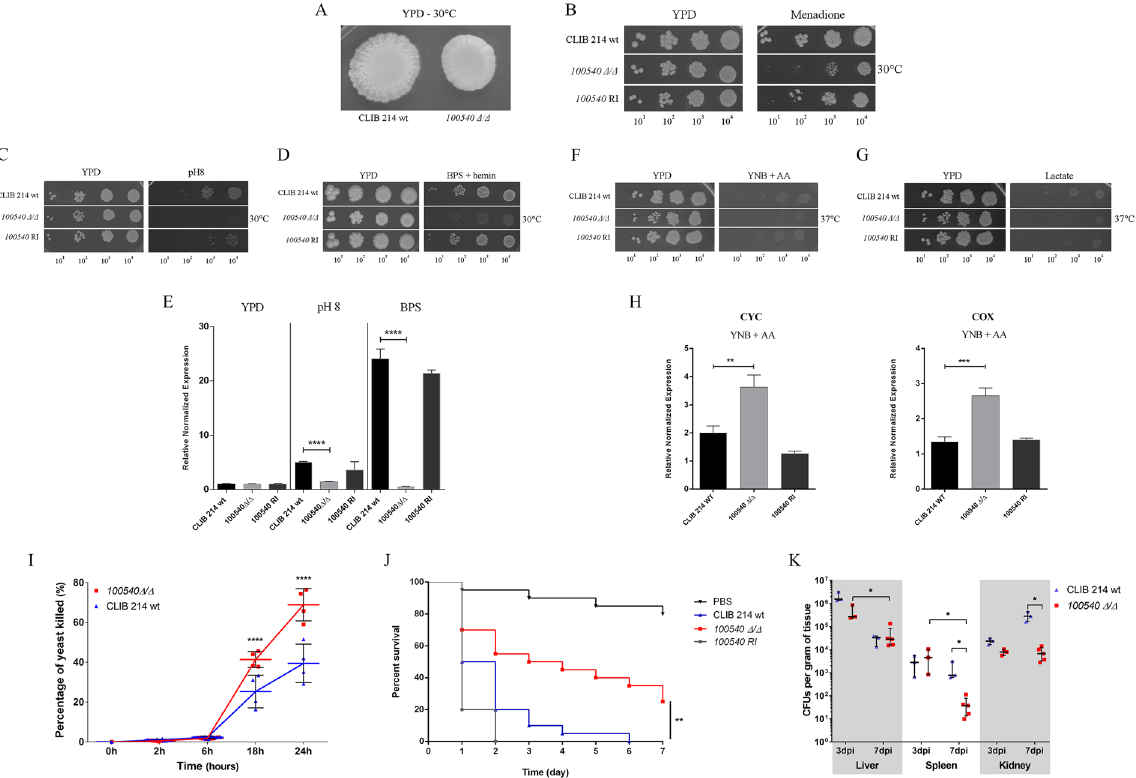
Figure 4. Phenotypic traits of the CPAR2_100540 Δ / Δ strain. ( A ) Colony morphology on YPD solid medium after 2 days of incubation at 30 °C. Growth of wild type (CLIB 214), CPAR2_100540 Δ / Δ and CPAR2_100540 reintegrant (RI) strains on ( B ) 0.015 mM menadione containing solid medium after 3 days, ( C ) on pH 8 medium after 2 days, ( D ) on 500 mM BPS + 2 μ M hemin supplemented media following 6 days, ( F ) on YNB + amino acid (AA) supplemented and ( G ) 2% lactate containing plates after 3 days of incubation, at the presented temperatures. Following growth assays, gene expression levels of the ( E ) C. albicans FRP1 ortholog, CPAR2_402880 was determined after cultivation of the three strains in both inductive (pH 8, BPS supplemented YPD) and non-inductive (YPD) conditions for 12 hours at 37 °C. ( H ) Relative normalized expression of CYC and COX gene orthologs ( CPAR2_407500 and CPAR2_207710 ) was also examined following cultivation in YPD and amino acid supplemented (AA) YNB medium at 37 °C. Statistical significance was determined by unpaired two-tailed t -tests ( ** p ≤ 0.01; *** p ≤ 0.001, ( **** p ≤ 0.0001). ( I ) Interaction between J774.1 macrophage-like cells and yeast mutants was followed for 24 h, with determinations made at 2, 6, 18, and 24 h. For 2 h N ≥ 5, 6 h N = 8, and for 18 h and 24 h N = 4, from 2 independent experiments. Virulence properties of the mutant strains was also investigated in vivo , examining ( J ) G. mellonella larvae survival and ( K ) organ colonization of BALB/c mice after infection. Statistical significance was determined by two-way ANOVA and Dunnett’s multiple comparisons tests in case of J774.1, unpaired Mann-Whitney test in case of BALB/c mice infection and Mantel-Cox (Log-rank) test after G. mellonella infection ( * p ≤ 0.05; **** p ≤